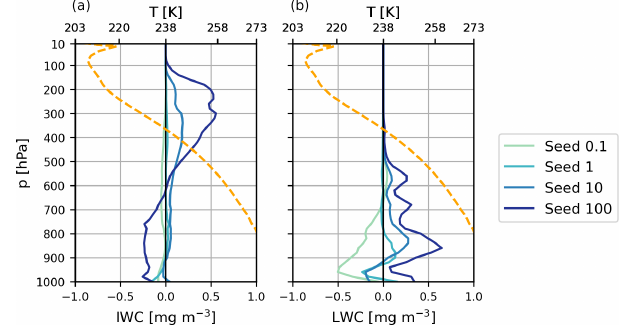
Figure 7. Five-year annual global mean (a) IWC and (b) LWC ver- tical anomaly profiles in mgm − 3 for D19 for all seeding particle concentrations for S i,seed = 1.05. The orange dotted line represents the 5-year global mean temperature vertical profile centred around the homogeneous freezing temperature limit